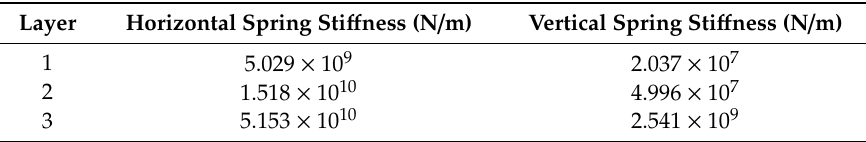
Table 4. Horizontal and vertical spring sti ff